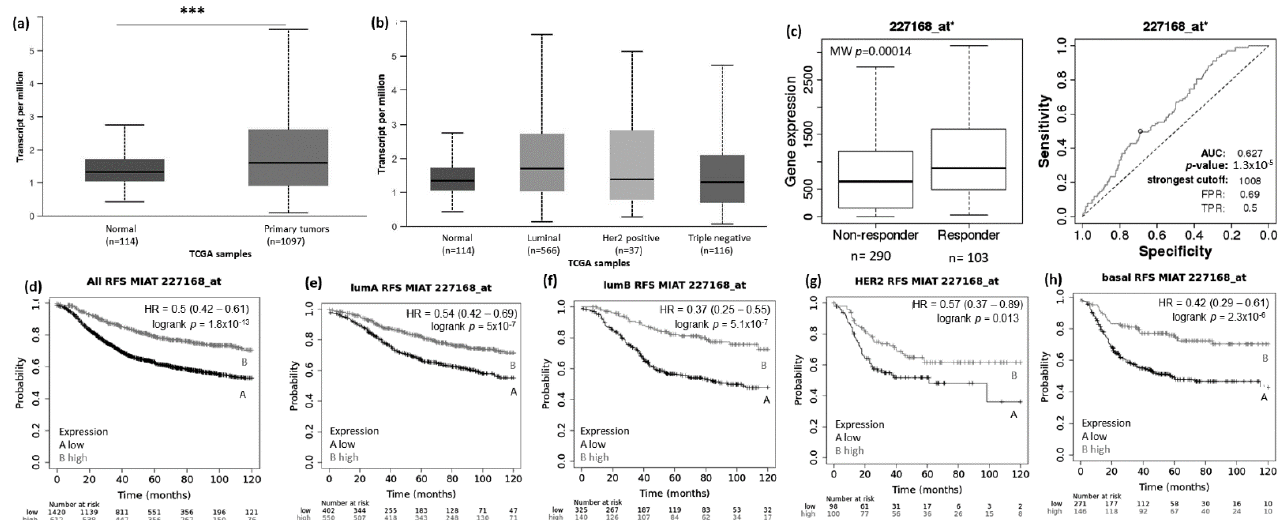
Figure 2. MIAT lncRNA expression in breast cancer patients and association with taxane treatment response and prognosis Expression of MIAT lncRNA in breast cancer compared to normal breast tissue ( a ) and among different breast intrinsic subtypes using the UALCAN database containing TCGA data ( b ). ( c ) MIAT lncRNA expression in groups of responder and non-responder breast cancer patients treated with taxane using the online platform ROCplot. ( d – h ) Kaplan–Meier curves for relapse-free survival of breast cancer patients for all subtypes ( d ) or for each intrinsic subtype as luminal A ( e ), luminal B ( f ), HER2 ( g ), and basal ( h ) grouped as high or low expression of MIAT according to the best cut-off value using the JetSet best probe set at the KMplotter online tool. *** p < 0.001; MW—Mann–Whitney